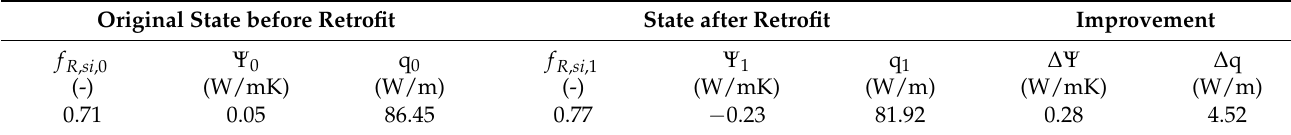
Table A9. Quantifiable results of the thermal bridge retrofit of an inside wall (ThermCad thermal bridge simulation calculation). Original State before Retrofit State after